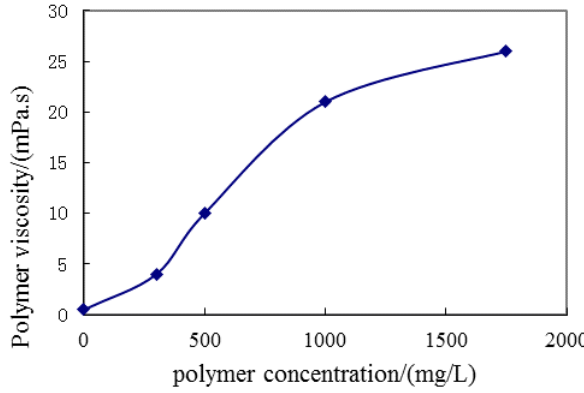
Figure 8. Viscosity of polymer solution against concentration.